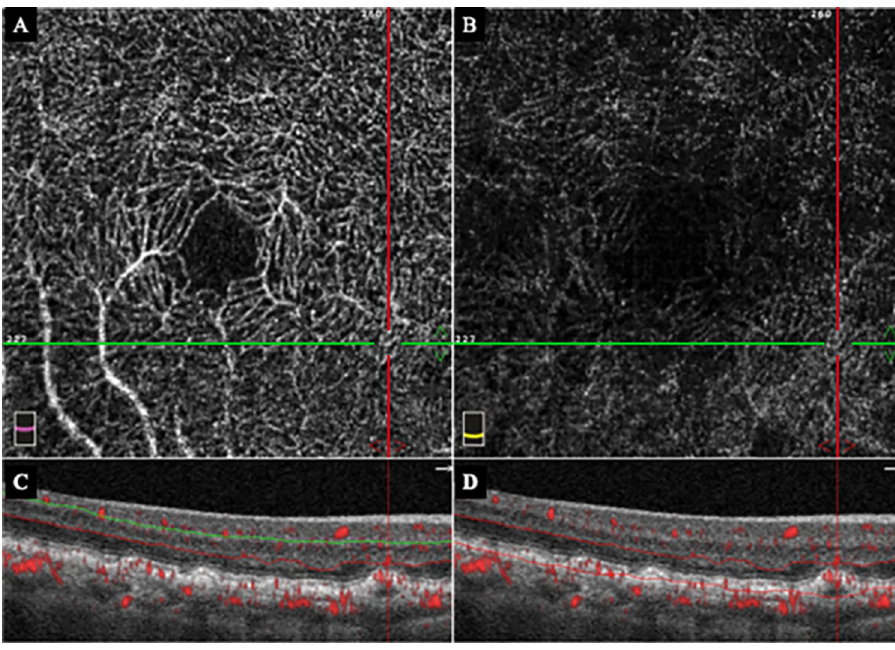
Fig 2. En face optical coherence tomography angiographic (OCTA) images of the right eye 3 months prior to the onset of the exudative type 3 MNV. Same case shown in Fig 1. A: Early en face OCTA image of the right eye showing deep capillary plexus (DCP) with abnormal blood pattern in the inferior-nasal area of the macula located at the intersection of the horizontal (green) and vertical (red) lines. B: Early en face OCTA image of the right eye showing that the outer retina (OR) region is normal. C: B scan OCTA image of the DCP segment overlayed with blood information shows abnormal blood pattern in the DCP segment. D: B scan OCTA image of the OR segment overlayed with blood information shows no abnormalities of the blood flow